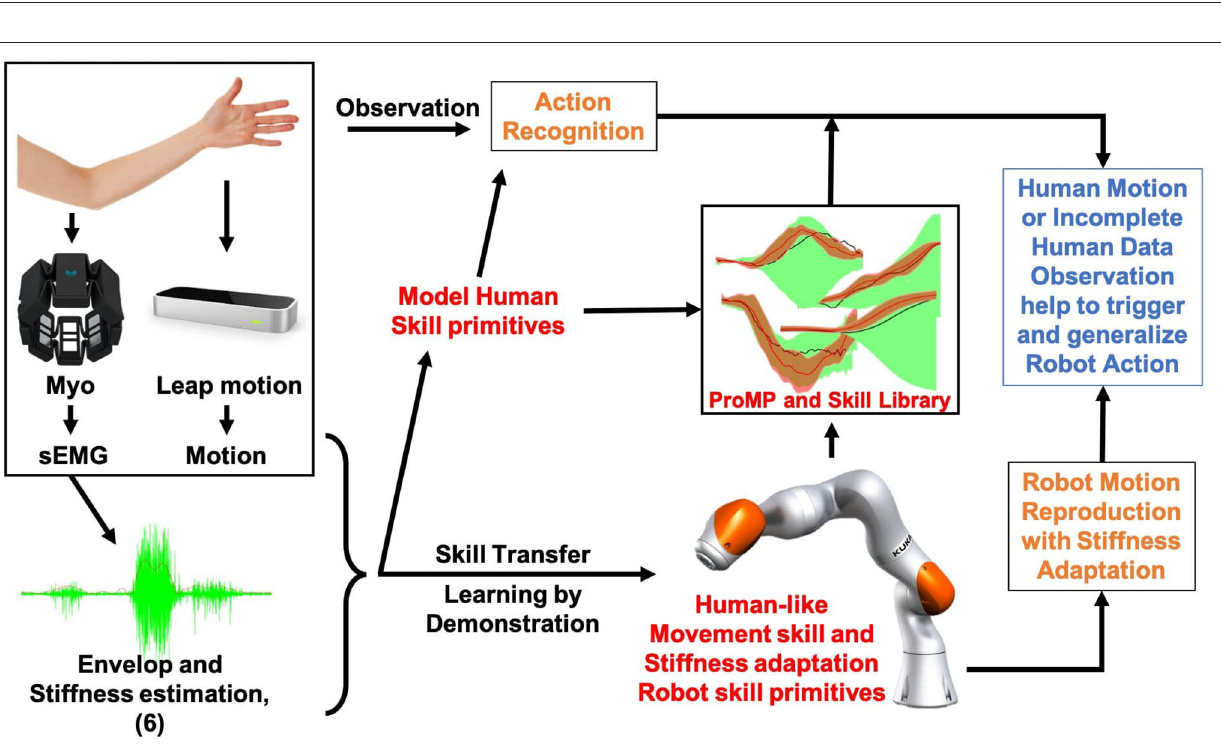
FIGURE 7 | Proposed motion with stiffness adaptation skill transfer and generalization